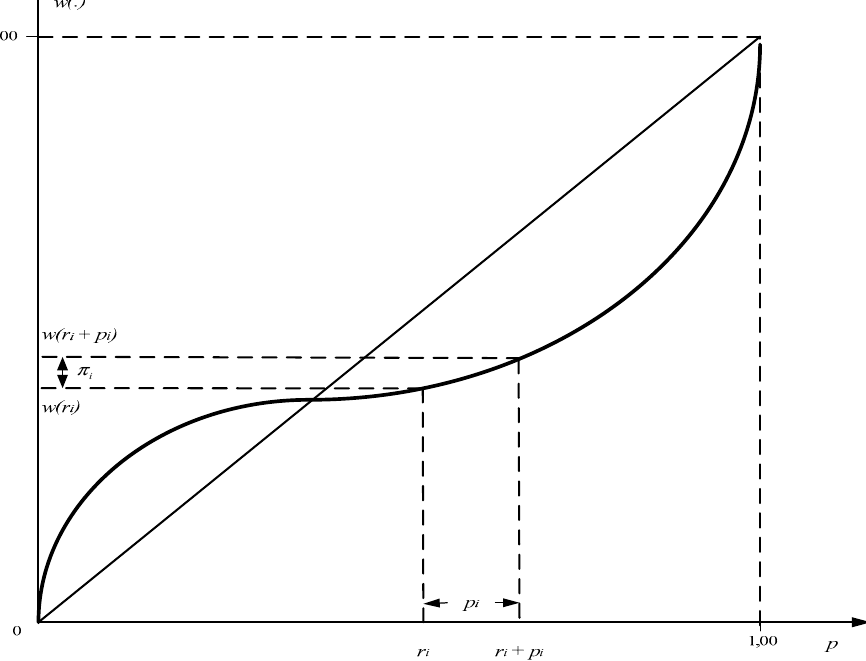
Figure 3. Schematic representation of the concept of decision weight in rank-dependent utility